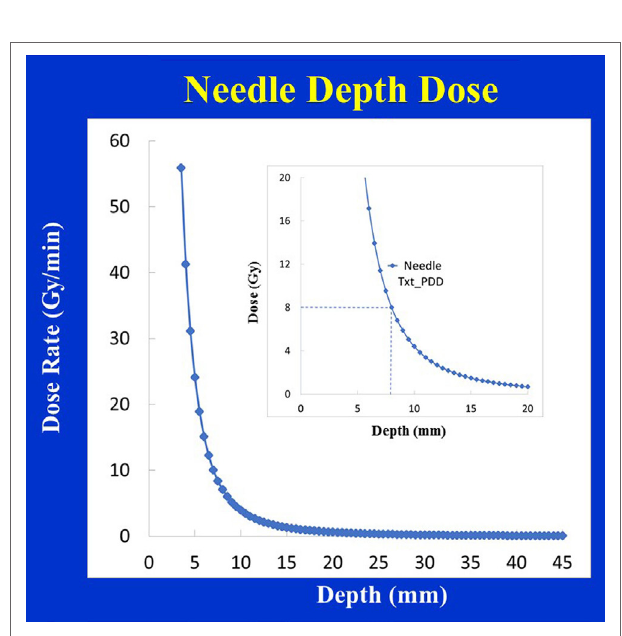
FigUre 13 | Depth-dose (DD) profiles for the Needle applicator (diameter 4.4 mm). Inset figure shows a prescribed dose of 8 Gy delivered at 8 mm from the source.